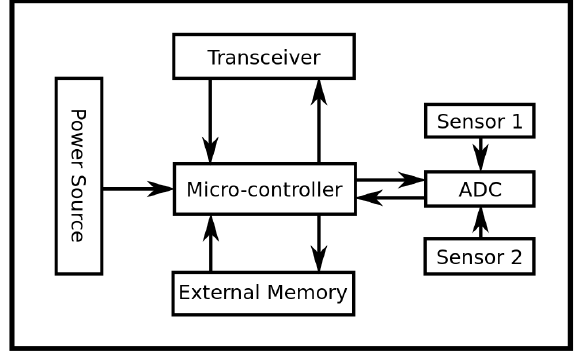
Figure 1. Wireless Sensor Node